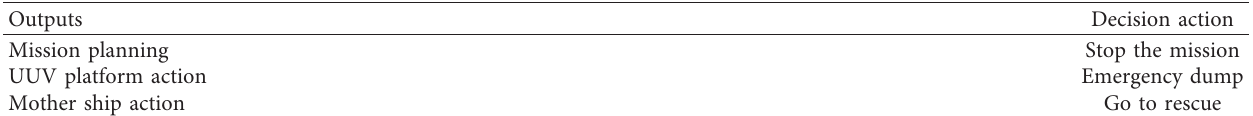
Table 10: Simulation output